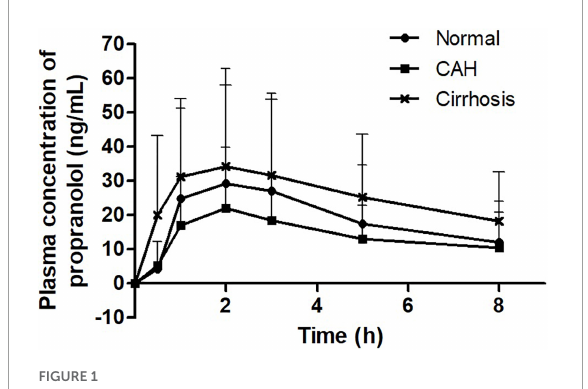
FIGURE1 Plasma concentration-time profiles of propranolol.